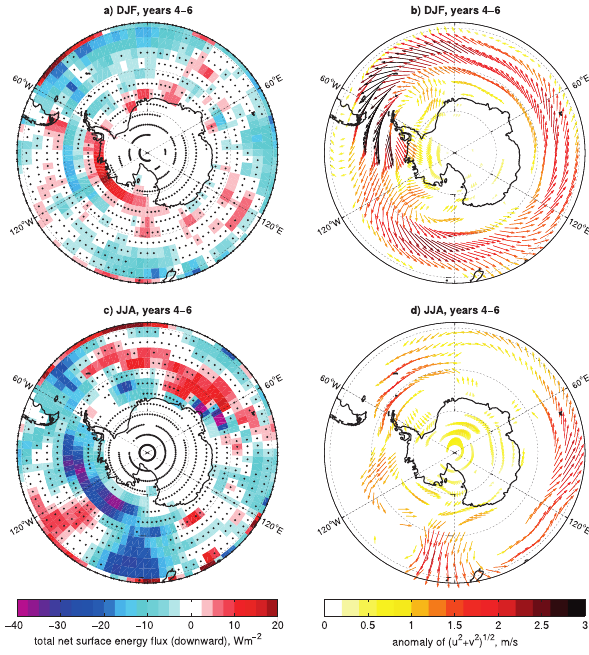
Figure 11. Ensemble-mean simulated Southern Hemisphere sum- mer (DJF, top) and winter (JJA, bottom) total net surface energy flux (latent and sensible heat, short- and long-wave radiation, a, c ) and 10m wind anomalies (b, d) for integration years 1–2 of the SUPER1 ensemble. (a, c) : black dots indicate grid points where changes are nonsignificant at the 95% confidence level; (b, d) : only changes statistically significant at 95% confidence for at least one of the wind components are shown.